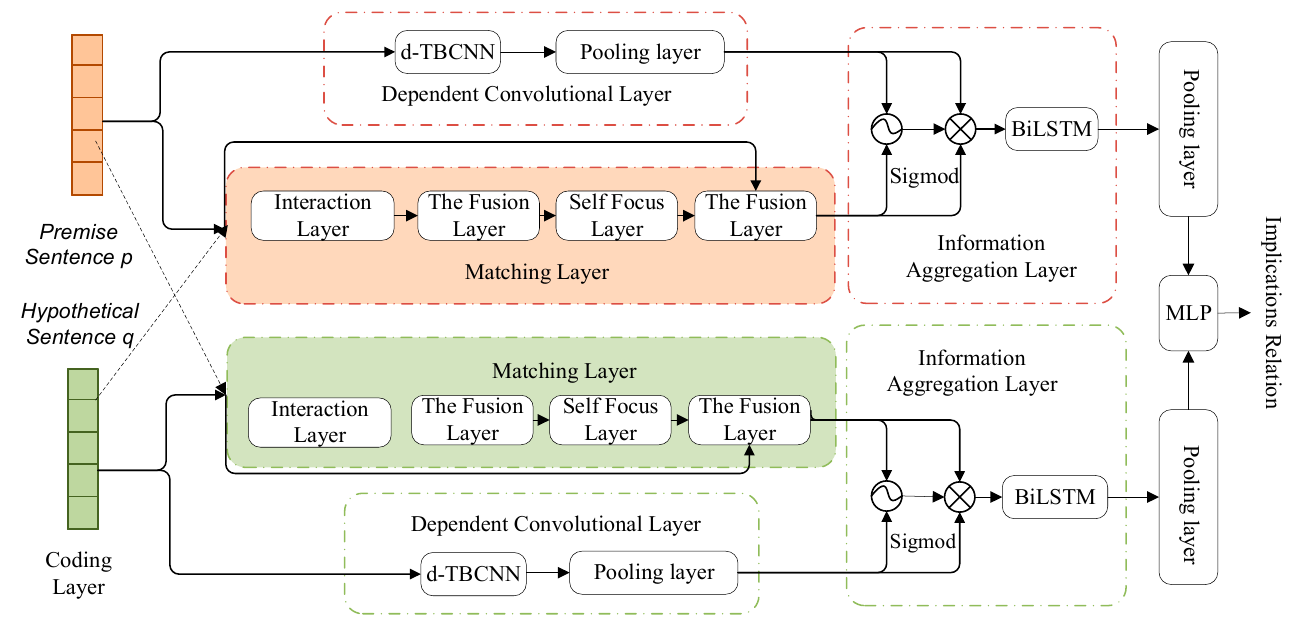
Figure 1. SCF-DMN network structure.